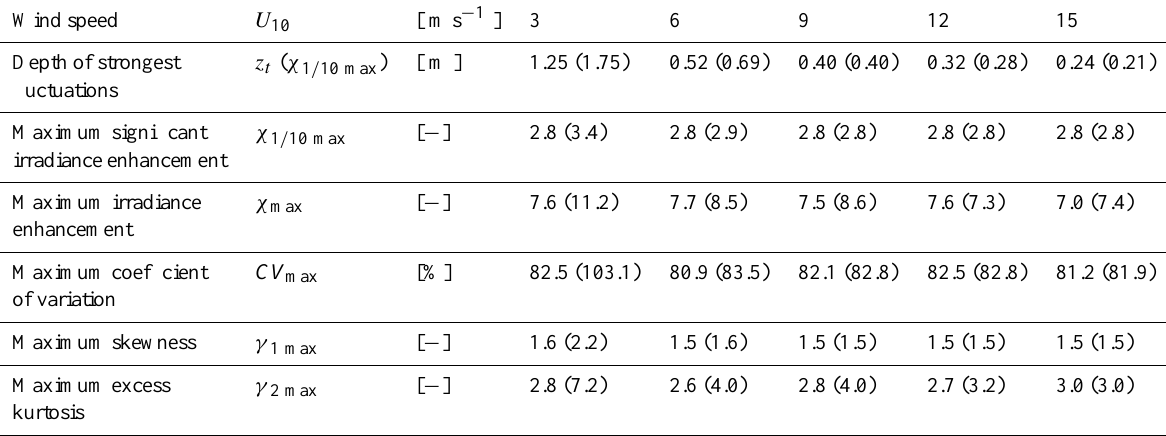
Fig. 6 : The influence of local wind on the underwater light field near the water 3 Fig. 6. The influence of local wind on the underwater light field near the water surface; (a) coefficient of variation CV of E d fluctuations; (b) significant irradiance enhancement χ 1 / 10 ; (c) mean fluctuation length L m ; (d) spectral peak length L p . surface; (a) coefficient of variation CV of E enhancement χ ; (c) mean fluctuation length L 1/10 Table 2. Numerical quantity values of maximum light fluctuations for different wind regimes; the numbers in brackets denote the influence of growing